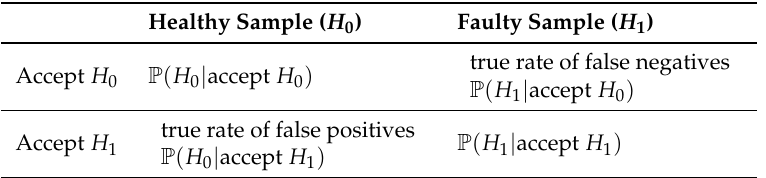
Table 8. Relationship between the proportion of false negatives and false positives.